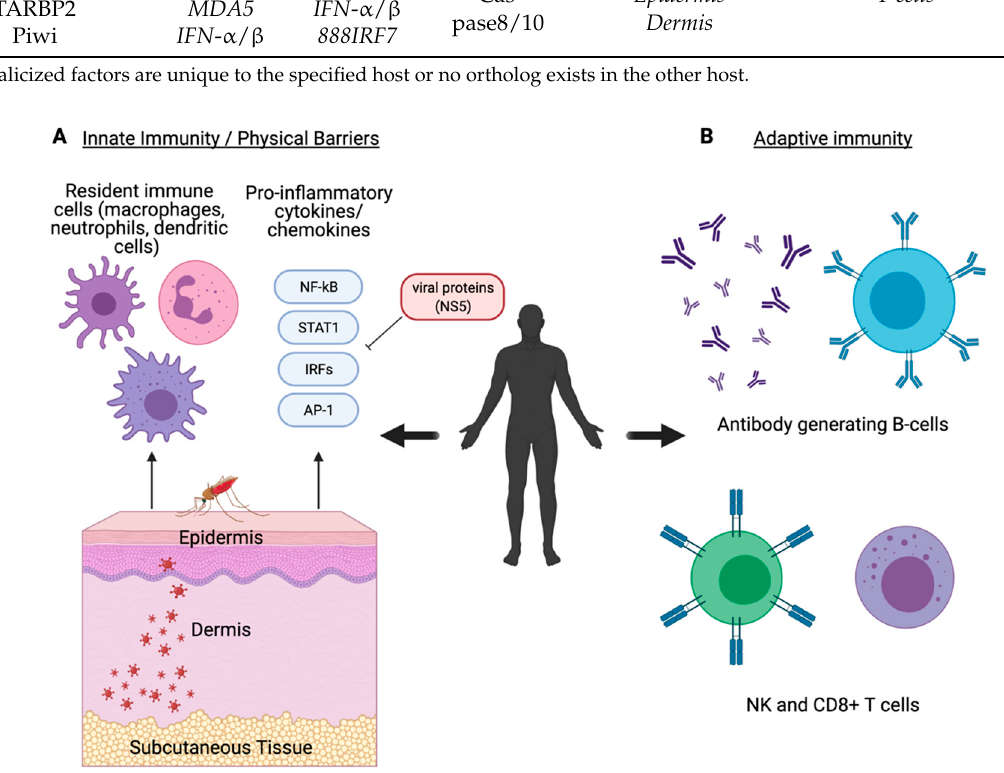
Figure 2. Innate and adaptive immune signaling in the human system. Humans defend against viral infections using physical barriers, innate immune signaling, and adaptive immune signaling responses. ( A ) Innate immune responses occur at physical barriers and involve the secretion of pro-inflammatory cytokines and chemokines by resident immune cells such as macrophages, neutrophils, and dendritic cells [126–129,131–133]. Components of the innate immune system are well conserved in both mosquitoes and humans. ( B ) The adaptive immune response primarily involves the generation of specialized and specific antibody-producing B cells, NK cells, and CD8+ T cells [134–140]. The adaptive immune response is a more evolved form of immunity that is unique to vertebrate organisms. Created with BioRender.com